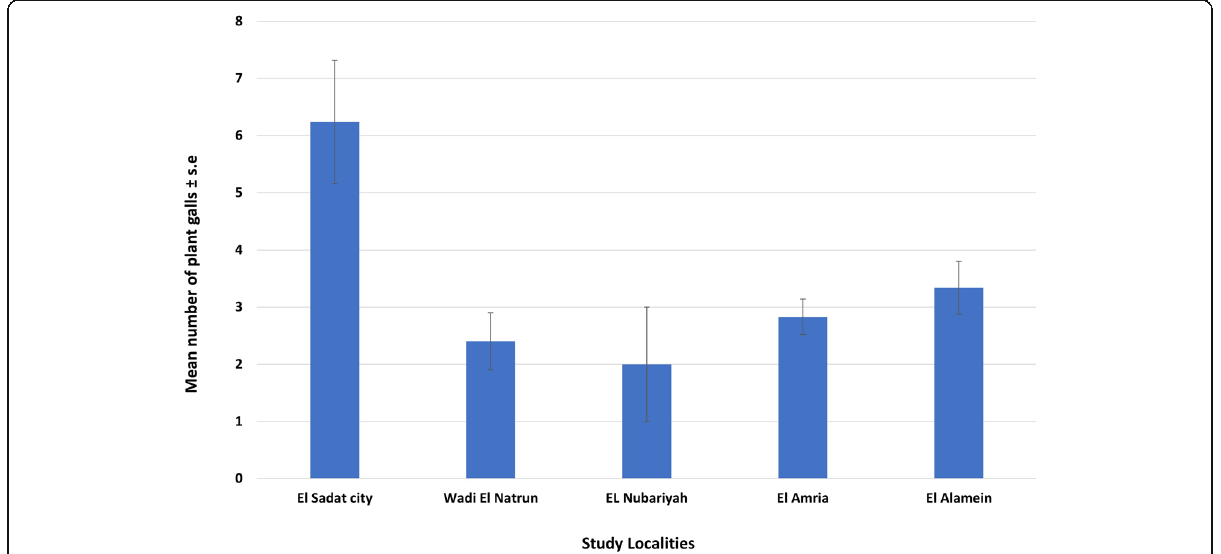
Fig. 5 The spatial pattern of gall distribution on the Deverra tortuosa among different study localities ( F (4, 86) =2.611, P <